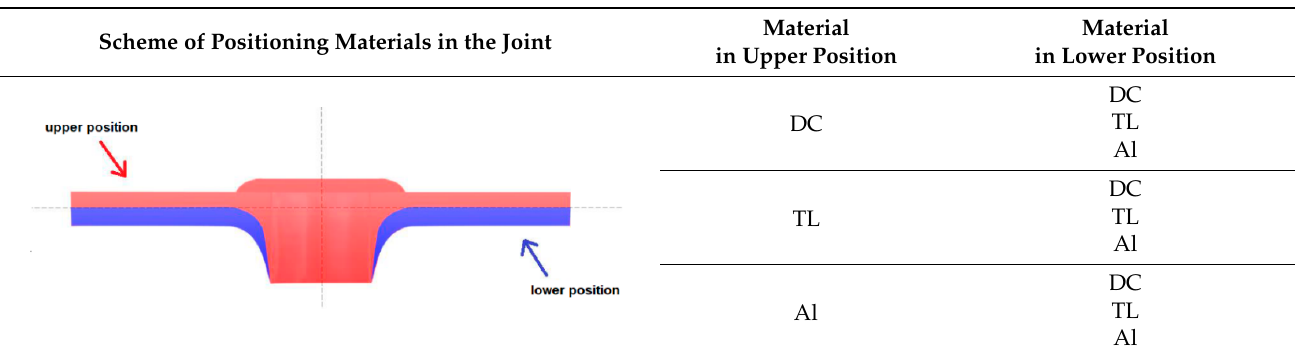
Table 4. Matrix of created joints.